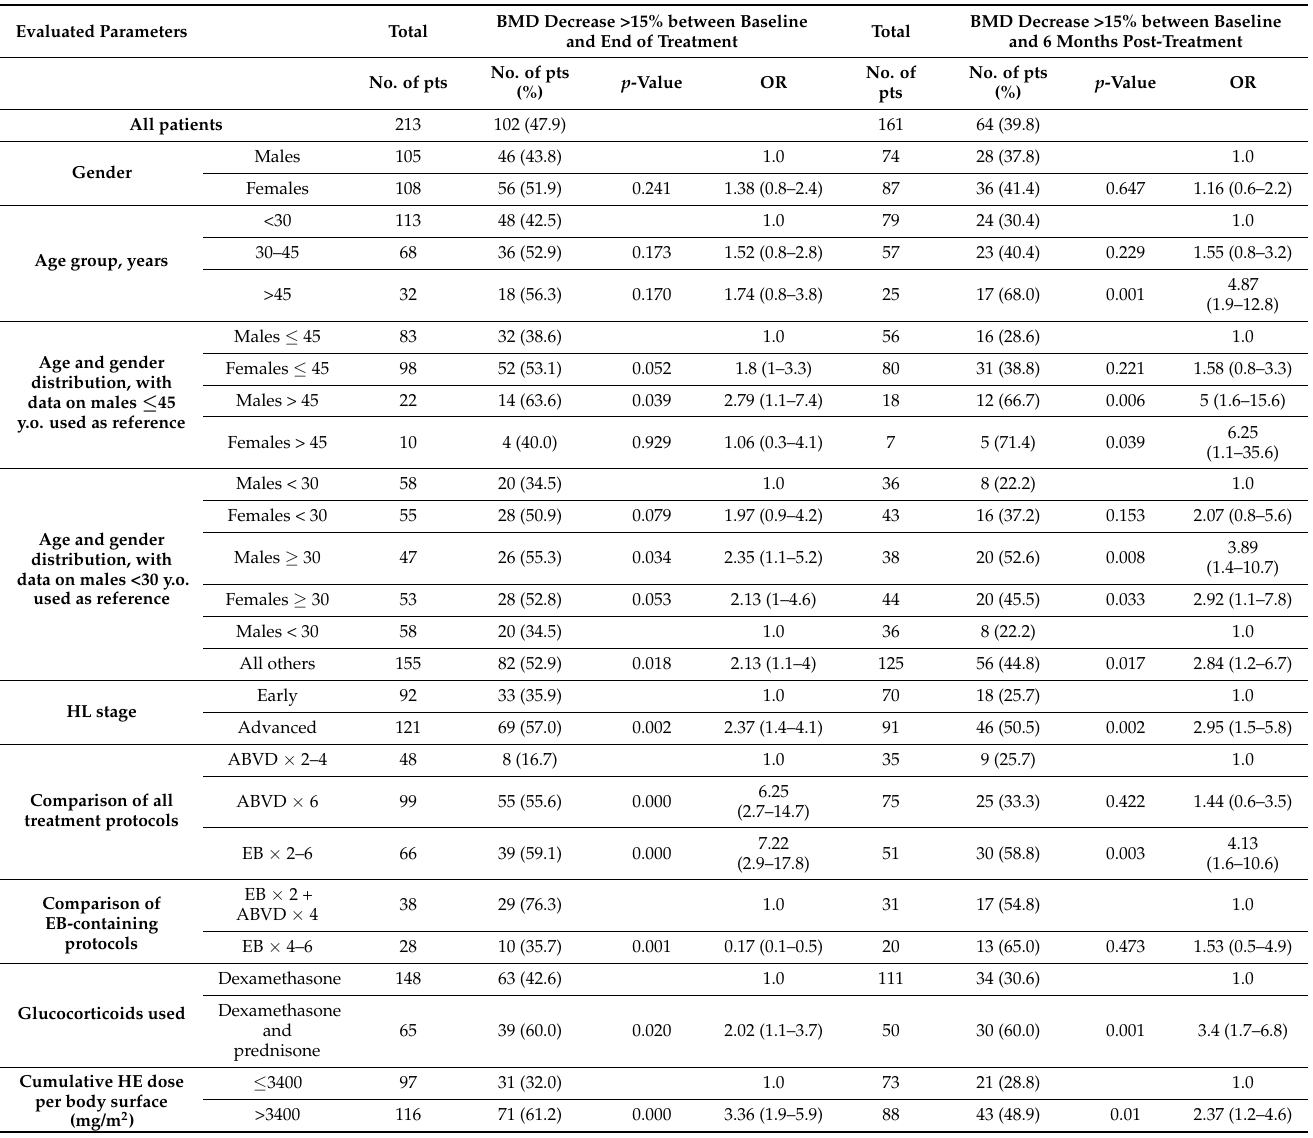
Table 4. Factors that influence BMD decrease of >15% between baseline and end of treatment, or between baseline and 6 months